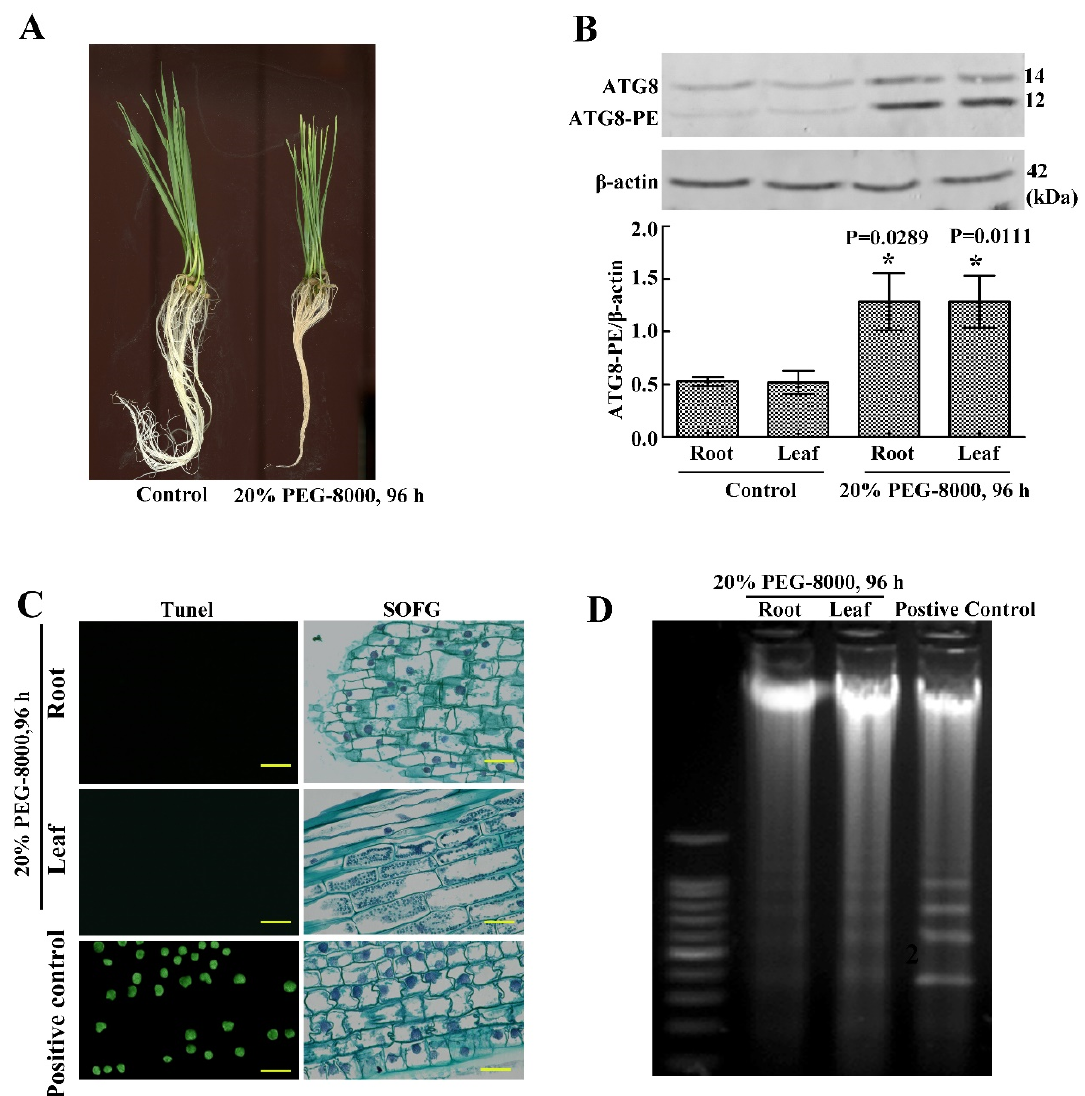
Figure 5. Autophagy as a method of cell survival in the roots and leaves of wheat seedlings following drought stress. ( A ) Phenotypes of wheat seedlings following treatment with 20% PEG-8000 for 96 h.